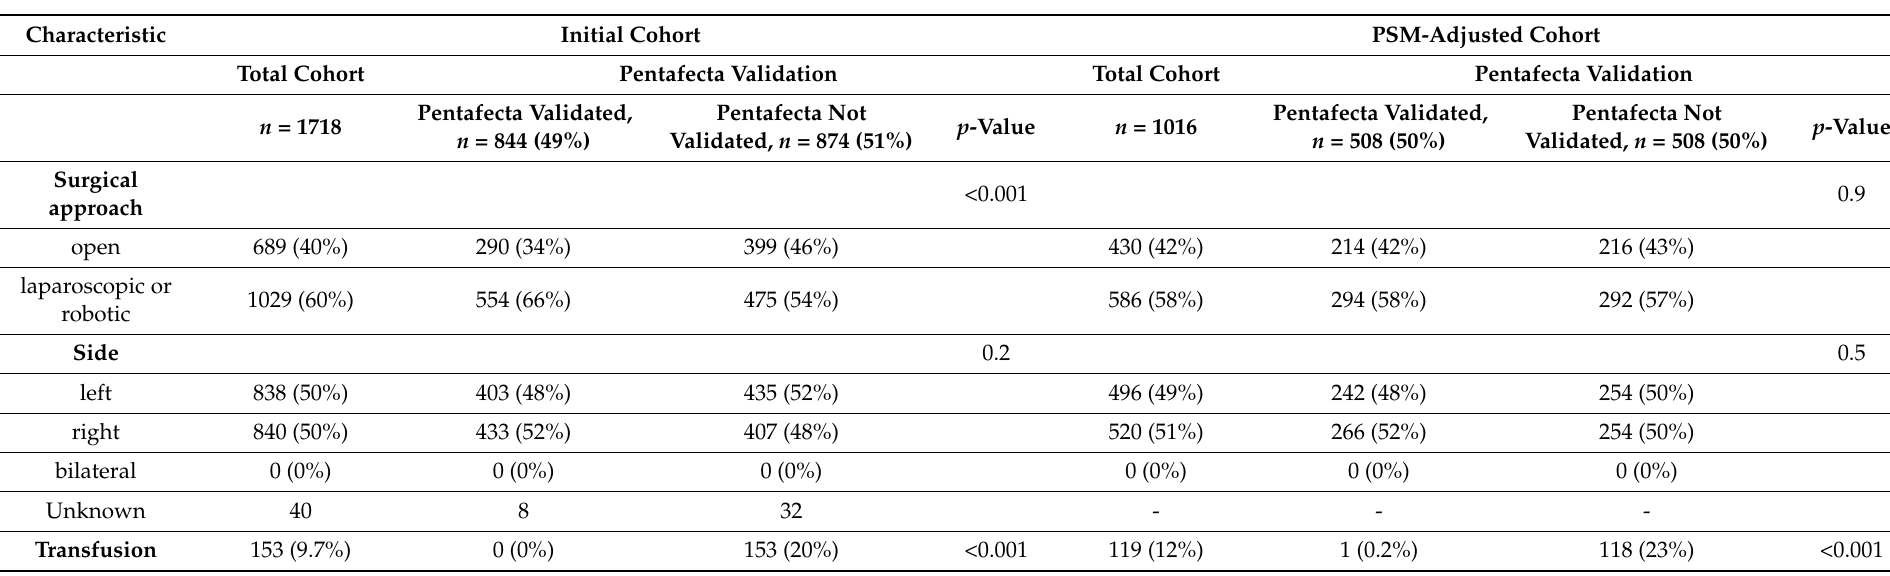
Table 2. Perioperative characteristics of 1718 patients treated with RNU for high-risk UTUC, initial cohort ( left ) and after propensity-score-matching adjustment ( right ), both stratified by pentafecta validation. PSM = propensity-score matching; CDC = Clavien–Dindo Classification; IQR = interquartile